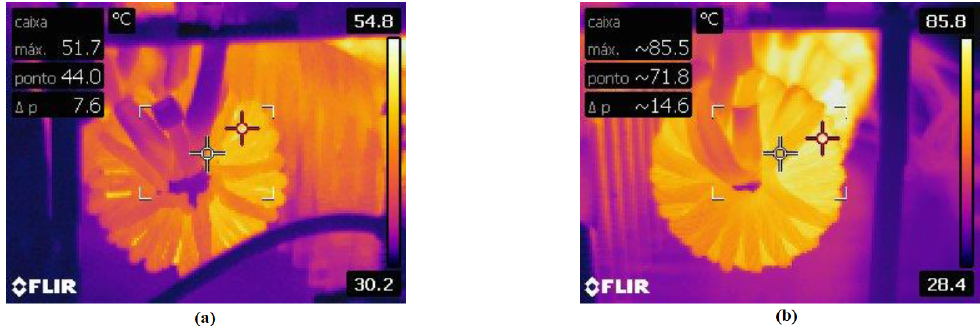
Figure 18. Thermal images for inductors operating at nominal power ( a ) Rectifier ( b ) Inverter.